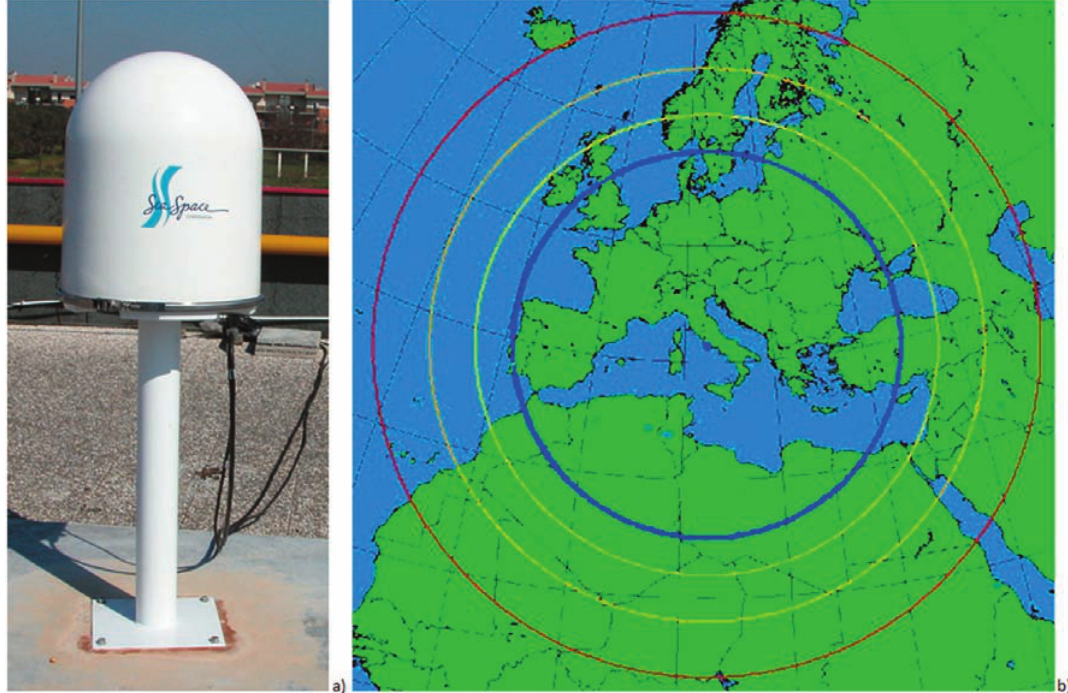
Figure 1. a) Photograph of the receiving antenna with radome installed on the roof of the INGV building, Rome. b) The inner blue circle represents the area of data acquisition in view of the L-band antenna located in Rome (blue point).